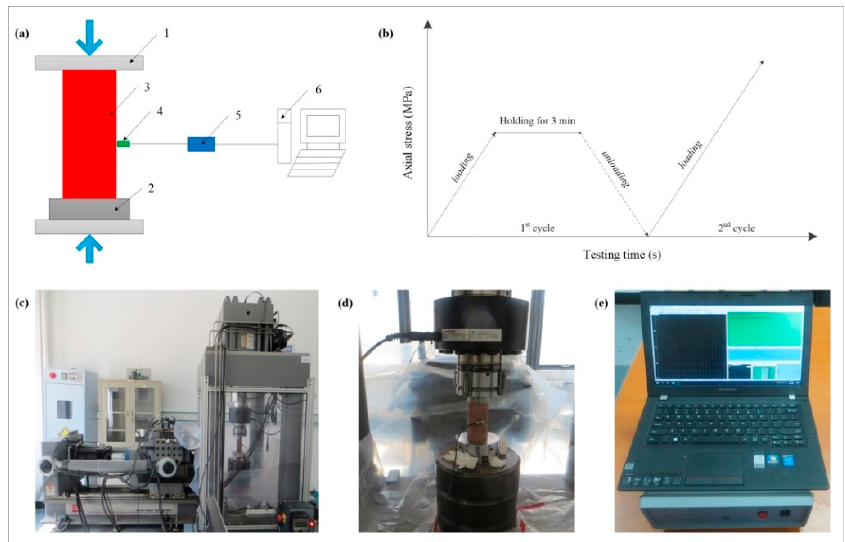
Figure 2. Configuration of the uniaxial cyclic loading and unloading test. ( a ) Schematic diagram, 1—loading platens of the testing system, 2—pedestal, 3—rock sample, 4—acoustic emission (AE) sensor, 5—AE per-amplifier, 6—data analyzer; ( b ) stress loading path; ( c ) MTS 816 rock mechanics